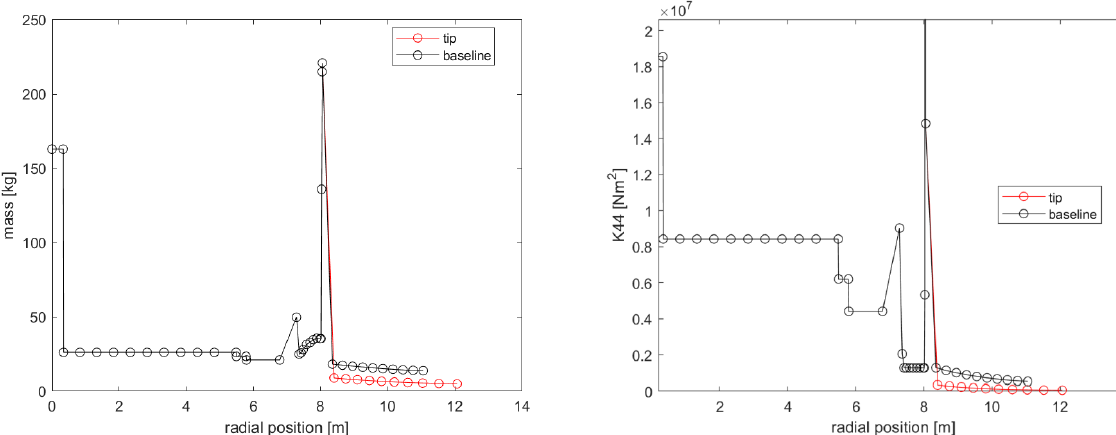
Figure 5. Mass and flapwise stiffness distributions of the tip compared to the reference.